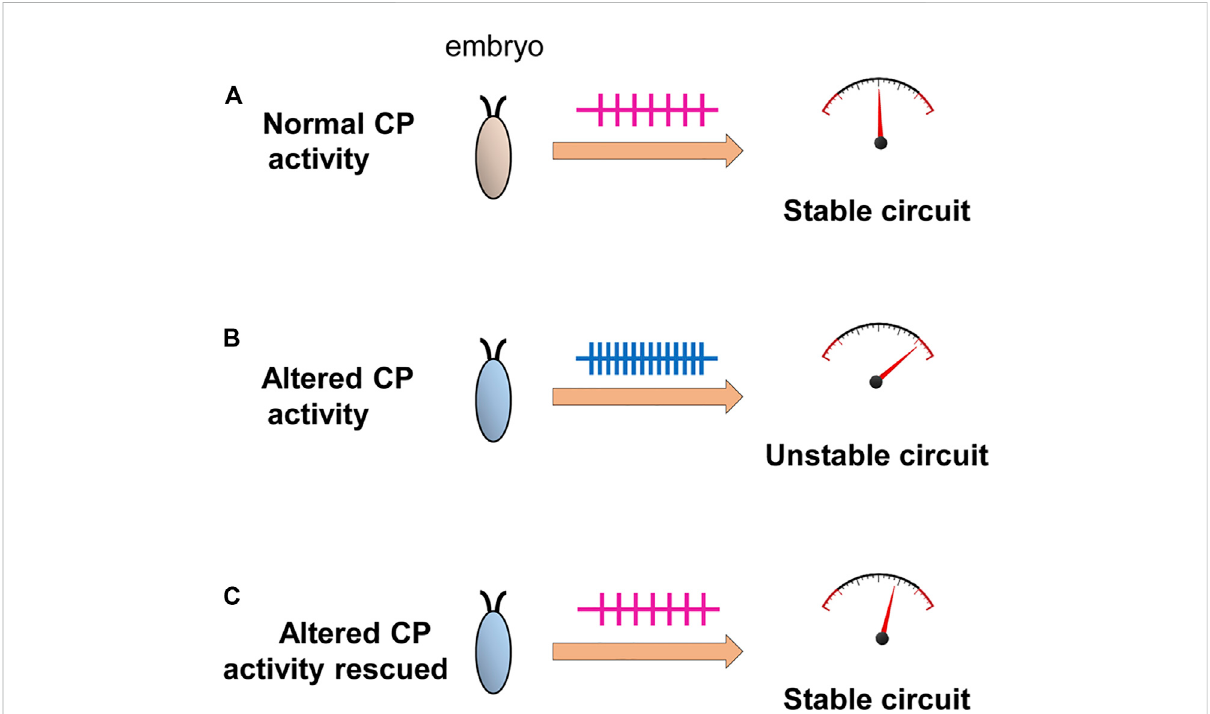
Activity-manipulation during the Drosophila locomotor CP alters network stability. Activity-manipulation during the locomotor CP is suf fi cient topermanentlyinduceaseizure-likephenotypeinlaterlarvae.This isindicative ofsigni fi cantandpermanentchangetoneuron/networkstability. (A) Normal activity patterns during a CP, in a wildtype embryo, may allow the setting of physiologically appropriate homeostatic setpoint(s) that ensure robustness (i.e., an ability to compensate for strong stimuli) of the locomotor network. (B) Altered activity during the CP, by contrast, sets inappropriate setpoints(s) pushing the mature network closer to being less stable, particularly when subjected to a strong stimulus (i.e., an electroshock). (C) RescueofactivityduringtheCP,inbackgroundswhereactivityisalreadyperturbed,issuf fi cienttopreventthechangesthatwould normally occur (Giachello and Baines, 2015) consistent with activity-rescue during this period forcing physiologically appropriate homeostatic setpoint(s) to be